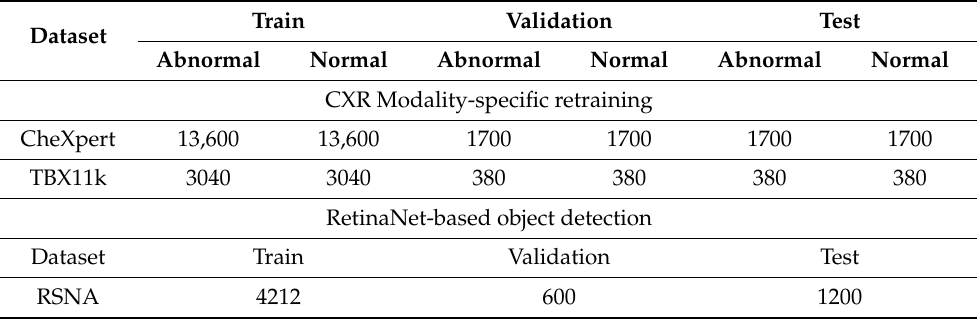
Table 1. Patient-level dataset splits show the number of images for CXR modality-specific retraining and object detection. Note: TBX11K and RSNA datasets have one image per patient.